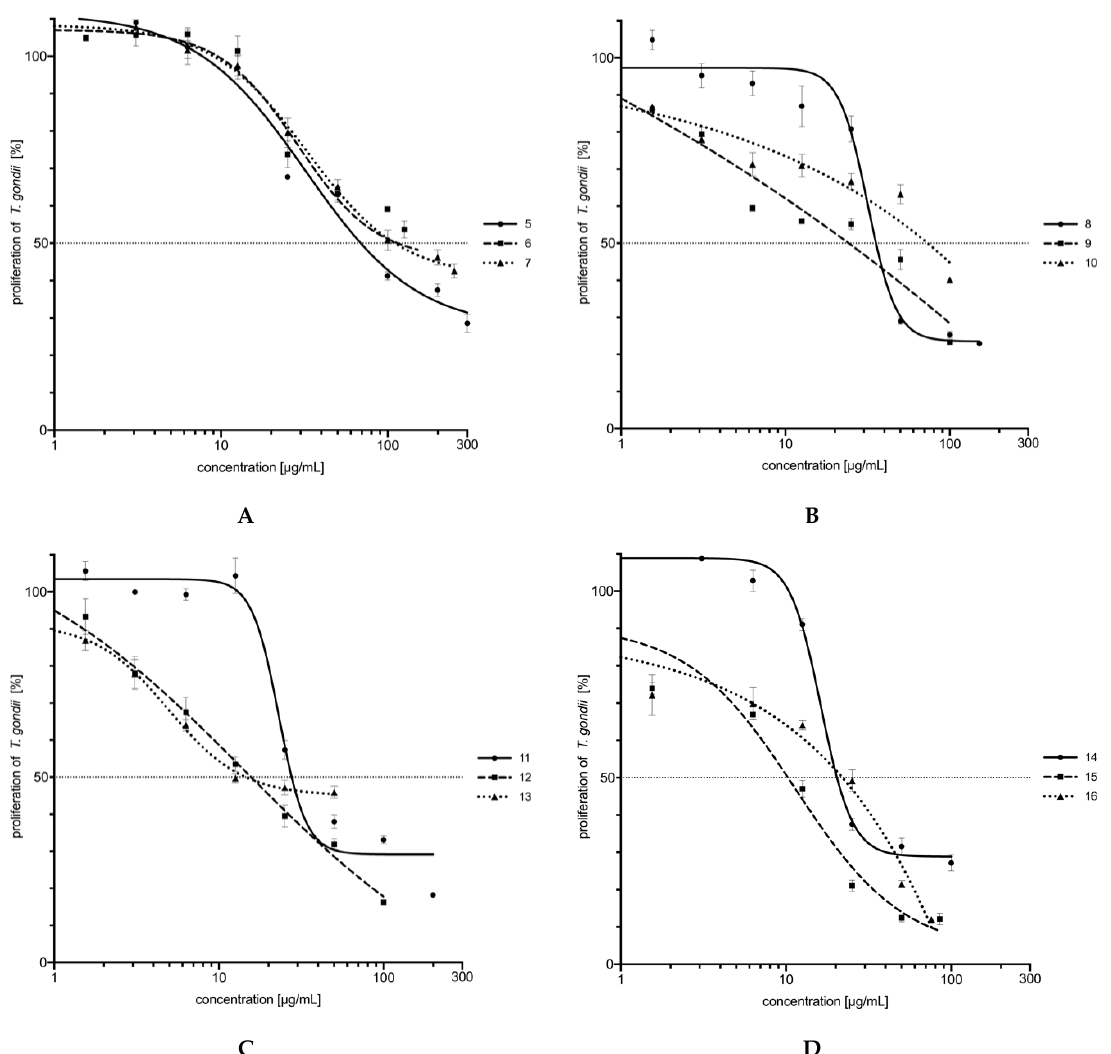
/ mL] of compounds 5 – 16 , ( A ) 5 – 7 , ( B ) 8 – 10 ,